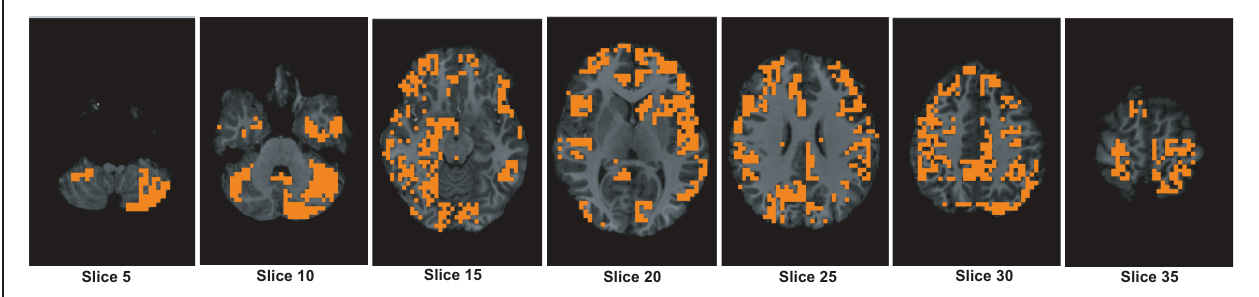
FIGURE A3 | The figure shows different slices to demonstrate the useful region mask computed using 3-cycle map features. The masked regions are highlighted in orange color and overlaid on the structural images of a sample